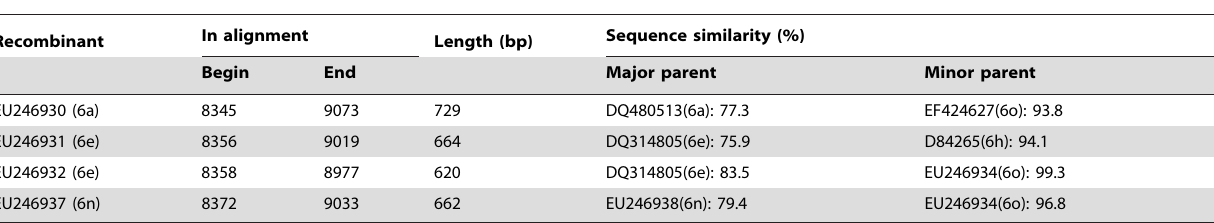
Table 3. Breakpoints of the four novel inter-subtype recombinants a .